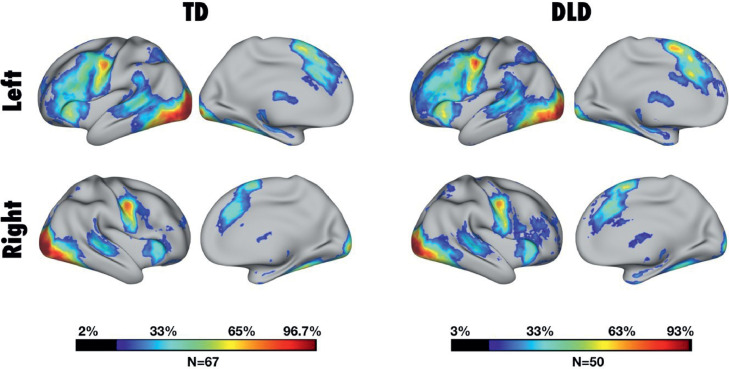
Probabilistic overlap maps showing consistently activated regions in children who were TD or DLD. Colours represent the percentage of participants that activate a specific area, with hot colours showing the greatest overlap and cool colours showing relatively limited overlap.